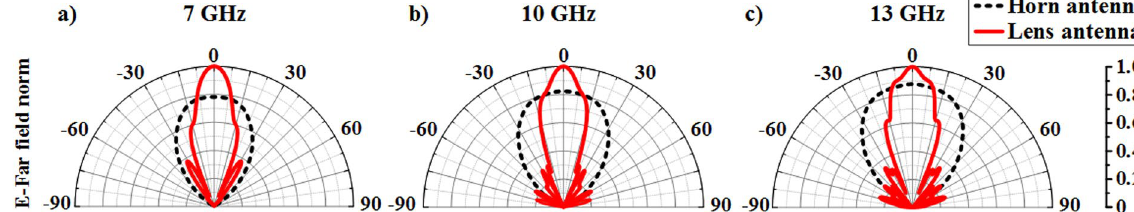
Figure 4. Normalized antenna radiation patterns showing the directionality enhancing performances of the cap lens antenna system at ( a ) 7 GHz, ( b ) 10 GHz and ( c ) 13 GHz.